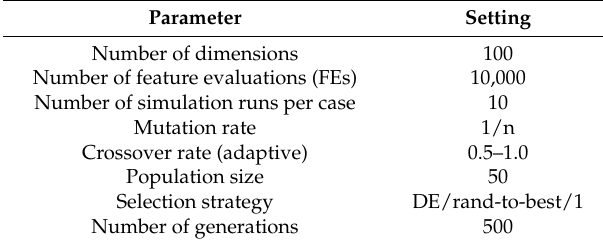
Table 1. Parameter Settings for Two-Objective Pareto-based Evolutionary